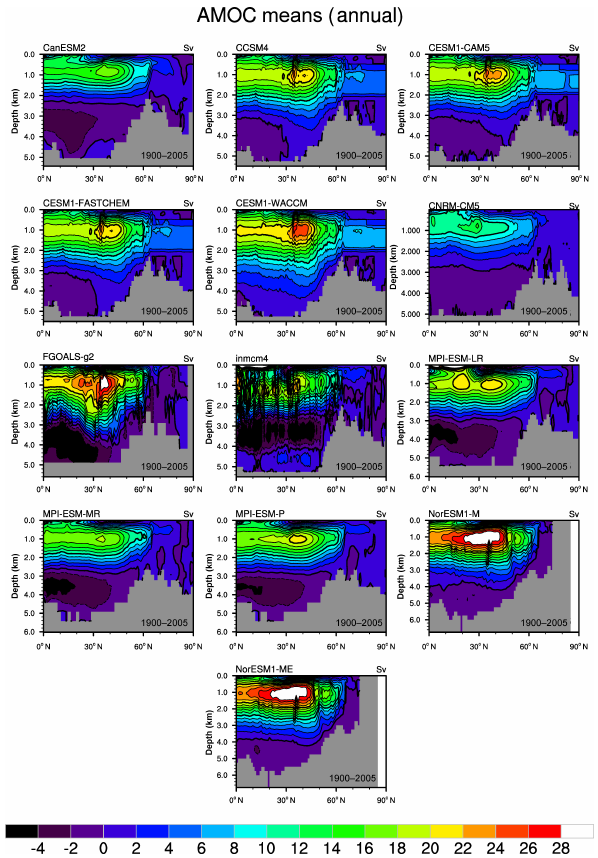
Figure 9. Long-term annual mean Atlantic Meridional Overturning Streamfunction (AMOC; Sv) as simulated by 13 CMIP5 models (individual panels labelled by model name) for the historical period 1900–2005. AMOC annual averages are formed, weighted by the cosine of the latitude and by the depth of the vertical layer, and then the data is masked by setting all those areas to missing where the variance is less than 1 × 10 − 6 . The figure shows that there is a wide spread among the CMIP5 models, with maximal AMOC strength ranging from ∼ 13Sv (CanESM2) to over ∼ 28Sv (NorESM1), while the models agree generally well on the position of maximal AMOC strength. Figure produced with namelist_CVDP.xml .